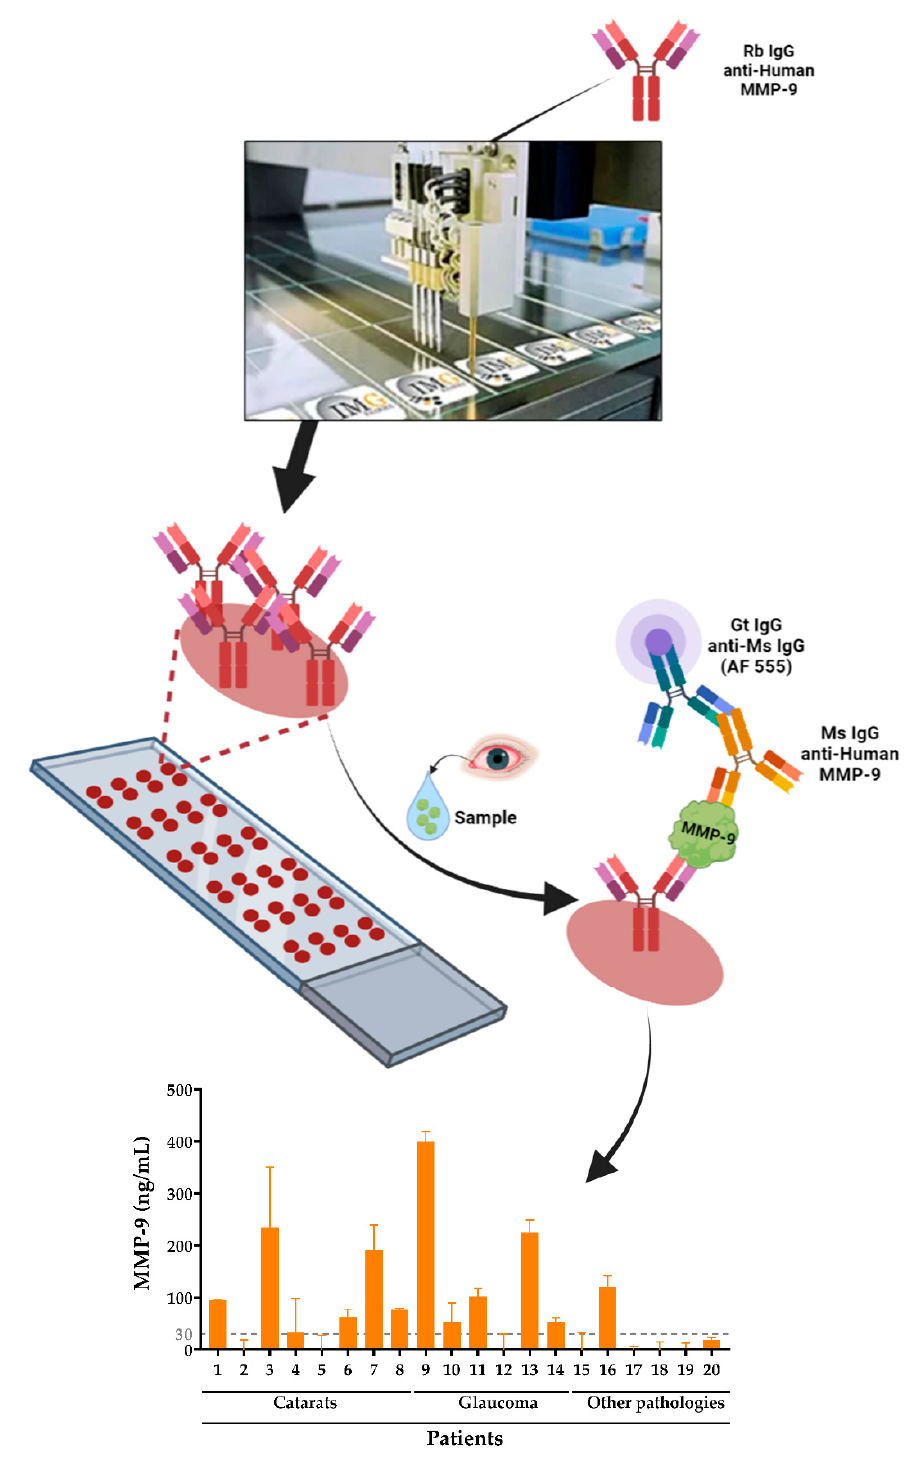
Figure 1. Detection and quantification of MMP-9 enzyme inflammation biomarker in human tear samples using AbMAs. First, the selected antibodies were immobilized onto glass slides that were incubated with the sample. Then, MMP-9 was captured by the mentioned antibody and detected with a labeled antibody cocktail. Finally, the intensity of the signal was quantified and the data acquired, allowing the analysis of the MMP-9 biomarker in the samples.